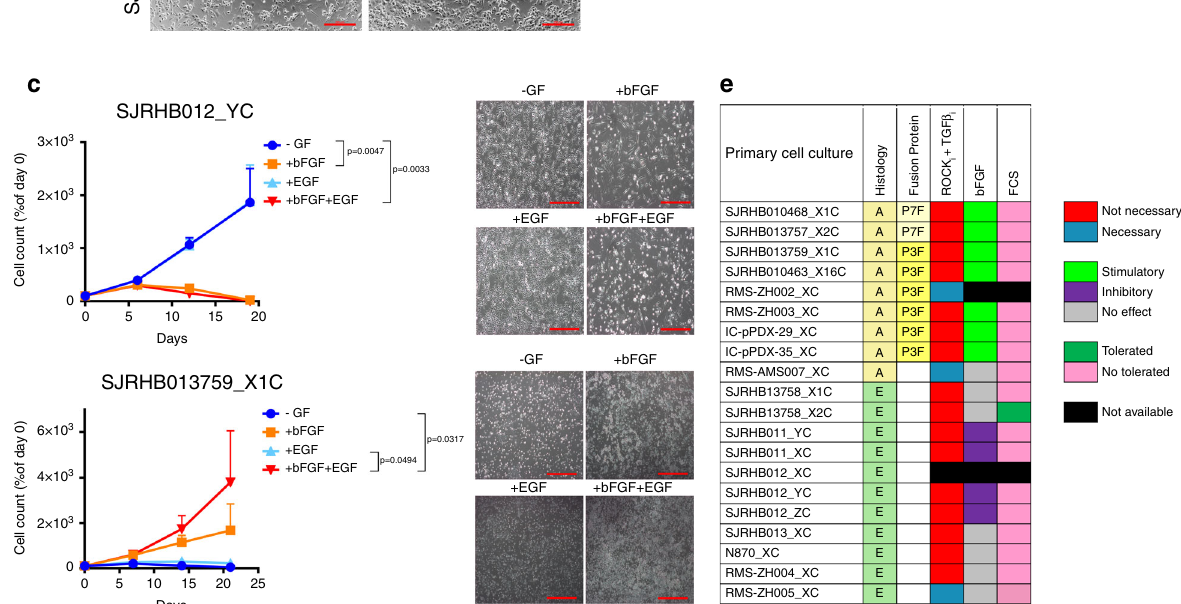
Fig. 2 Culture condition dependencies distinguish subgroups of RMS. a Heat map displaying the ratio of cell viability scores (as calculated from data shown in Fig. 1b and corrected for mouse contamination) in presence and absence of GFs ( + /- GF) for FN-RMS (left) and FP-RMS (right) PPCs. Light and dark purple colors indicate a negative and positive in fl uence of the GF on cell viability, respectively. White color represents a range of negligible effect. b Representative bright- fi eld images of indicated cells at passage 1 cultivated with or without GF stimulation. Scale bar, 200 μ m. c Assessment of GF dependency for long-term proliferation of GF-inhibited (SJRHB012_YC, upper panel) and GF-stimulated (SJRHB013759_X1C, lower panel) cells. Each data point is expressed as percentage of day 0. (Mean ± range; n = 2 biological replicates; two-way ANOVA with Tukey ’ s multiple comparisons test). c , right panel, Representative light-microscopy images of the respective cells taken at passage 2. 100X magni fi cation. d Histograms displaying cell counts over time for two PPC lines (RMS-ZH004_XC, SJRHB012_YC) cultivated under indicated conditions. -GF and + GF indicate the absence and presence of growth factors in the culture, respectively. (Mean ± range; RMS-ZH004_XC 0-14 days n = 3 biological replicates, RMS-ZH004_XC 21 days and SJRHB012_YC, n = 2 biological replicates; two-way ANOVA with Dunnett ’ s multiple comparison test). e Heat map summarizing growth conditions found to be optimal for indicated PPCs. NB, NB medium supplemented with 2xB27, Adv.DMEM/F12, Adv.DMEM/F12 medium supplemented with 0.75xB27, Y-27632, A83-01 and N-acetylcysteine. Source data are provided as source data fi